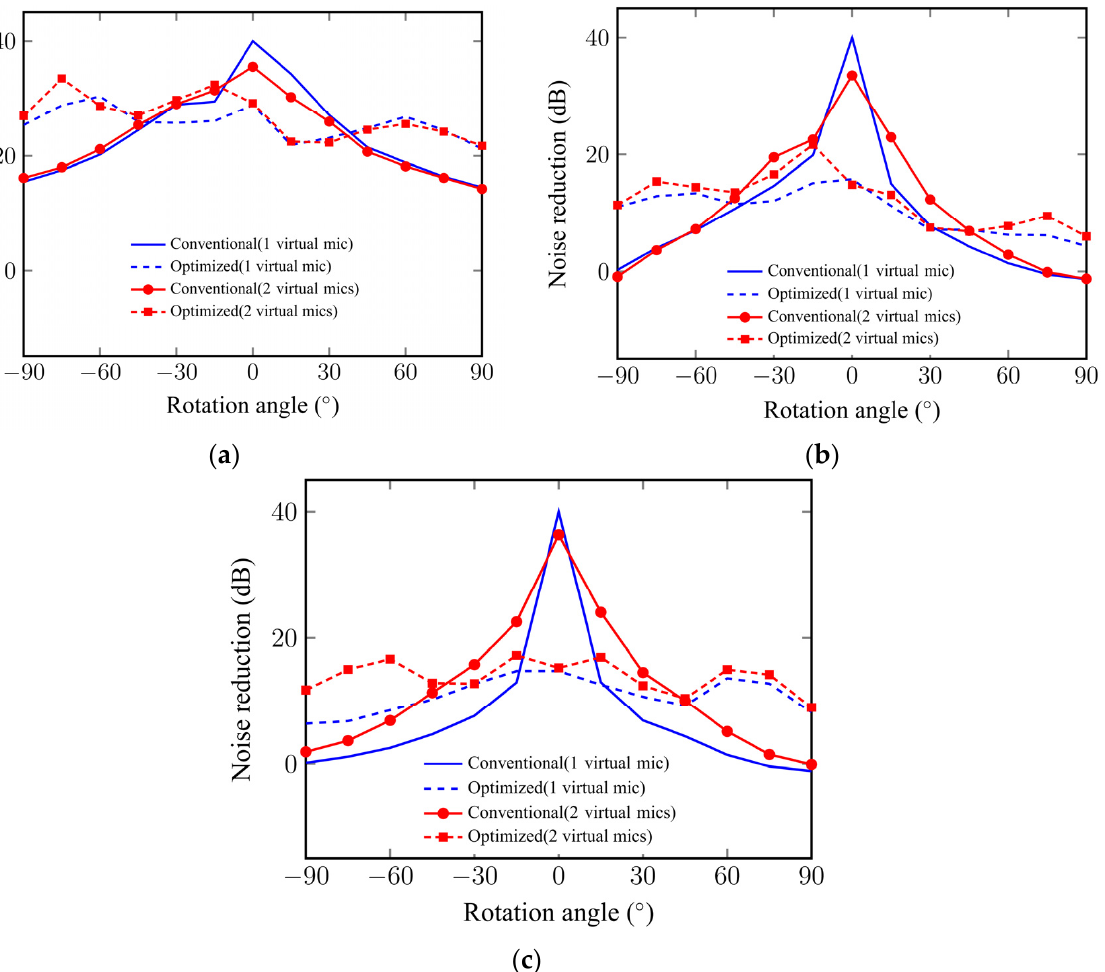
Figure 16. Noise attenuation when head rotates at ( a ) 125 Hz, ( b ) 250 Hz and ( c ) 500